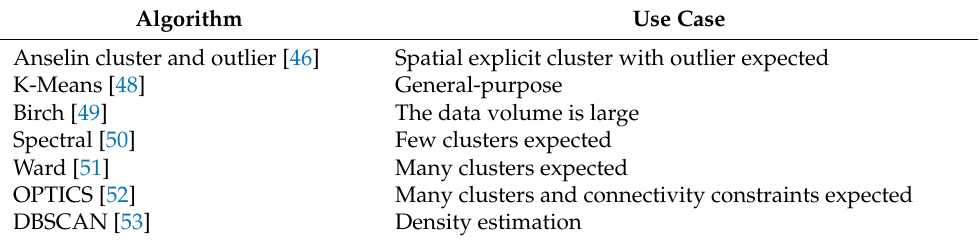
Table 1. Clustering algorithms supported by the knowledge discovery engine component.